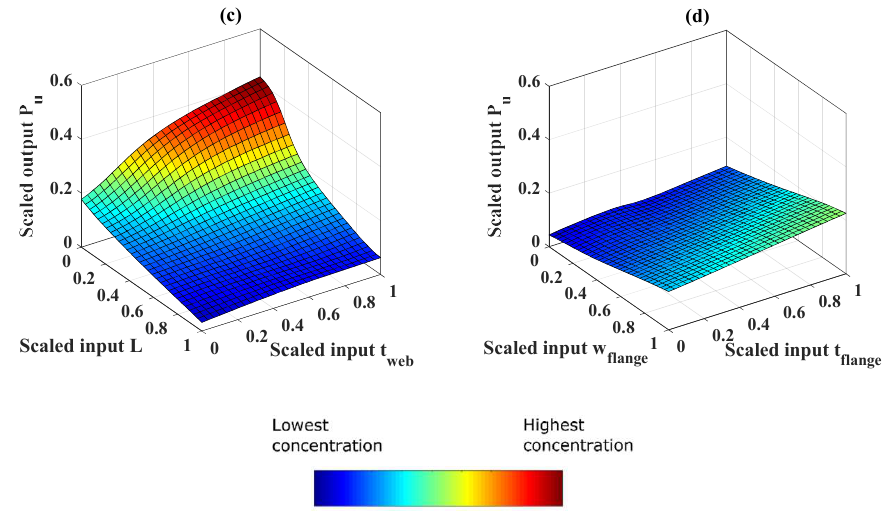
Figure 17. Three-dimensional scaled input–output maps: ( a ) L-w flange , ( b ) L-t flange , ( c ) L-t web , and ( d ) w flange -t flange .